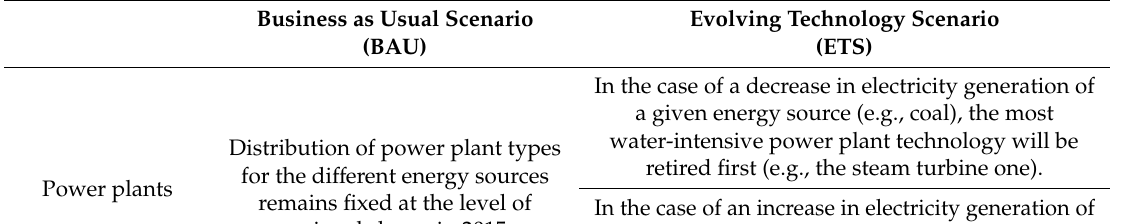
Table 2. Overview of power plant type and cooling technology scenarios developed in this